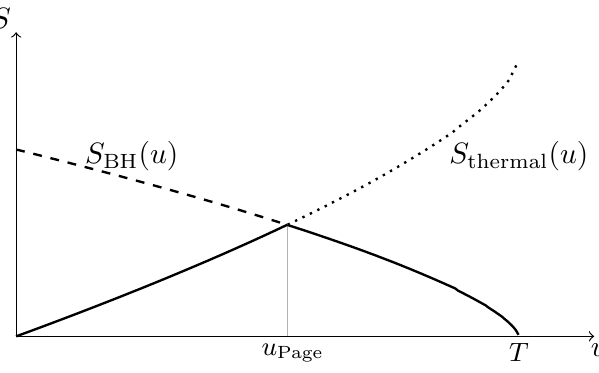
Figure 1. The Page curve for the entropy of Hawking radiation emitted before time u (solid curve). For a while this is increasing, given by the thermal entropy (dotted curve). But under BH unitarity it is bounded by the Bekenstein Hawking entropy S BH ∼ A (dashed curve). Consequently, after 4 G the Page time u Page the entropy must decrease, approximately saturating that